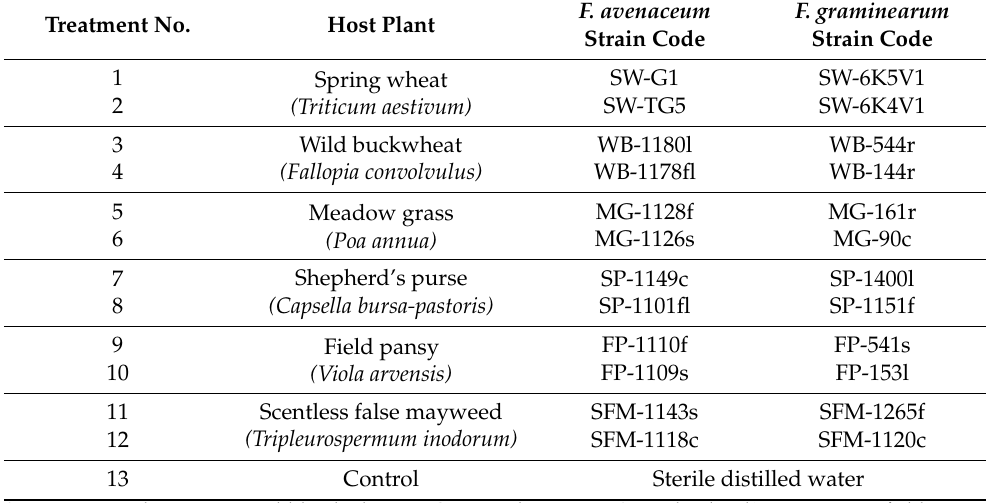
Table 1. The study scheme. Treatment